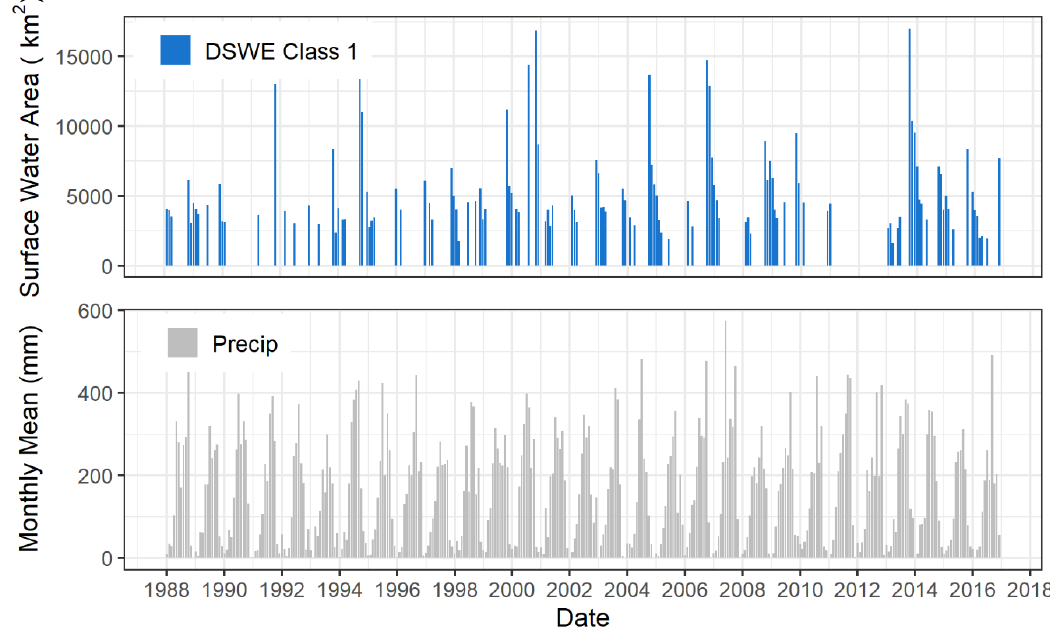
Figure 8. Monthly surface water area (top) and corresponding monthly average precipitation (bottom) for Cambodia, 1988–2018. Data are derived from historical monthly National Center for Atmospheric Research precipitation records and DSWE Class 1 (“high confidence water”) totals.